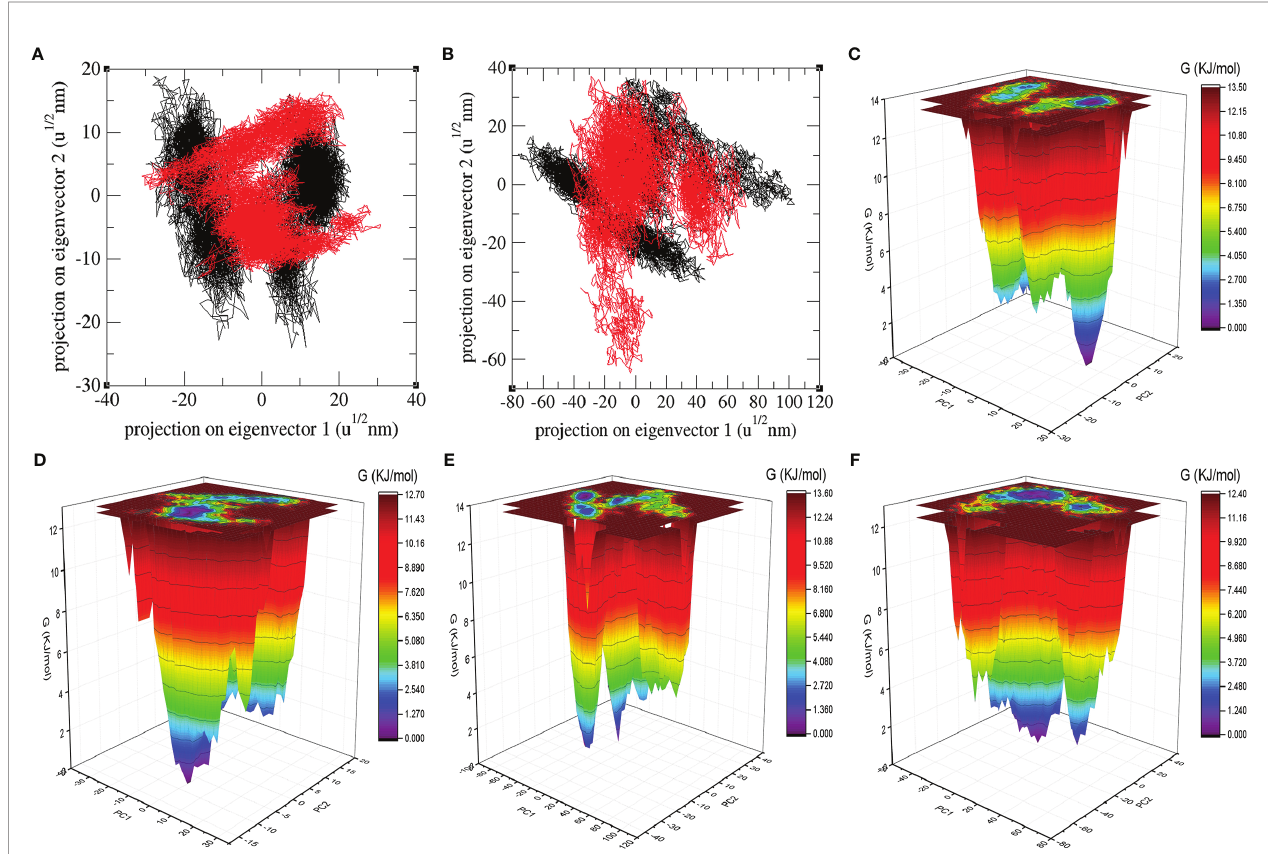
FIGURE 5 | Atomic projections and Gibbs energy landscape. The atomic projections on eigenvectors indicated different states of (A) Mprotease (black) and Mprotease-psilacetin (red), (B) HIK6 (black) and HIK6-psilacetin (red). The GFE landscapes are plotted for (C) Mprotease, (D) Mprotease-psilacetin, (E) HIK6, and (F) HIK6-psilacetin,